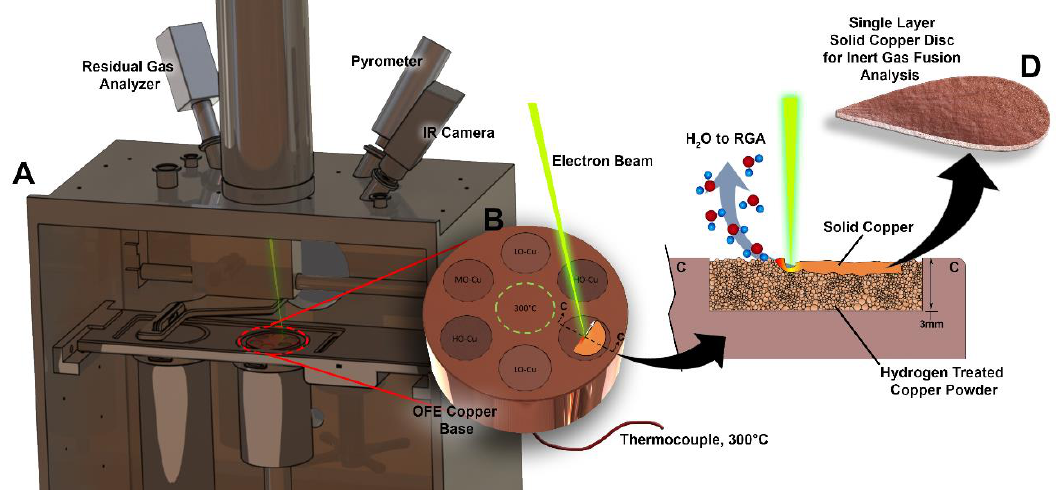
Figure 4. Illustration of the in-situ H 2 O vapor out-gassing experiment. The electron beam melting (EBM) vacuum chamber is outfitted with a residual gas analysis (RGA) and IR camera, and the surface temperature is monitored by a two-color pyrometer and thermocouple ( A ). The base fixture contains six 3 mm deep pockets ( B ), which are filled with hydrogen-treated and untreated powders with varying initial oxygen content. A single layer disc is melted on the top surface of each powder type. During melting, H 2 O is released from the powder or melt pool, and detected by the RGA ( C ). Upon completion, the powder is manually removed from the solid disc of copper, which is analyzed for oxygen and hydrogen content by inert gas fusion ( D ).